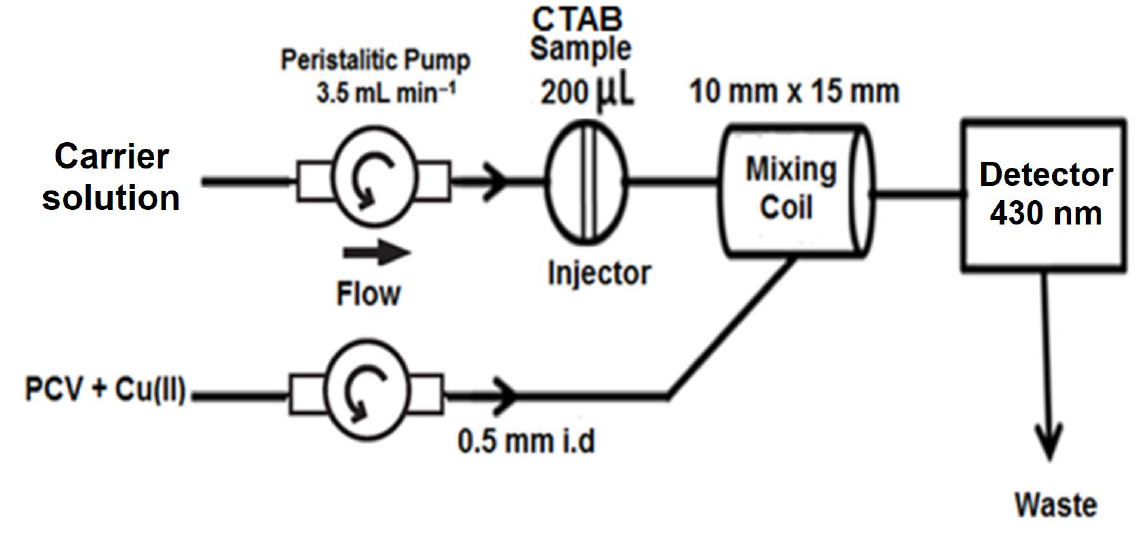
Figure 3. Online manifold for determination of CTAB in water and personal care products.